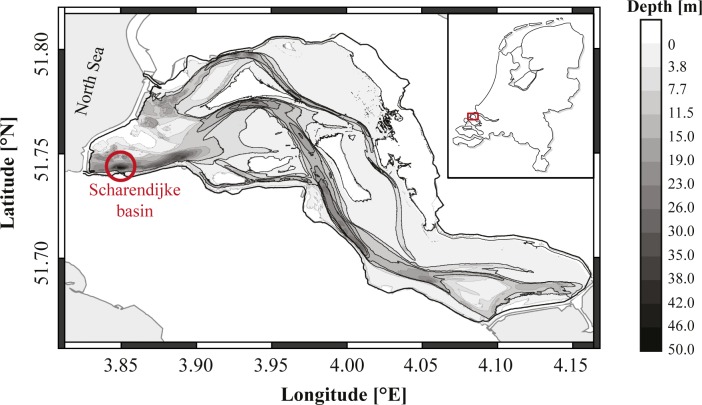
Bathymetric map of marine Lake Grevelingen.Cores were taken in the Scharendijke basin (51.742°N, 3.849°E; red circle) between 2012 and 2015. The red rectangle indicates the location of Lake Grevelingen in The Netherlands (NL).